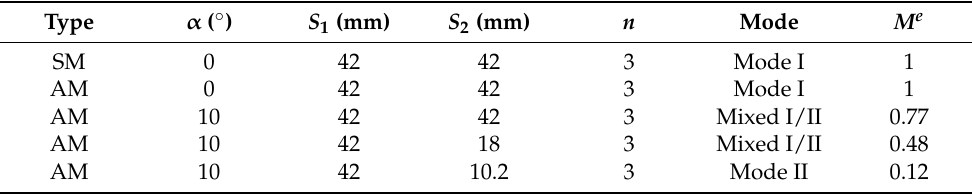
Table 2. Geometrical parameters of the test configurations.